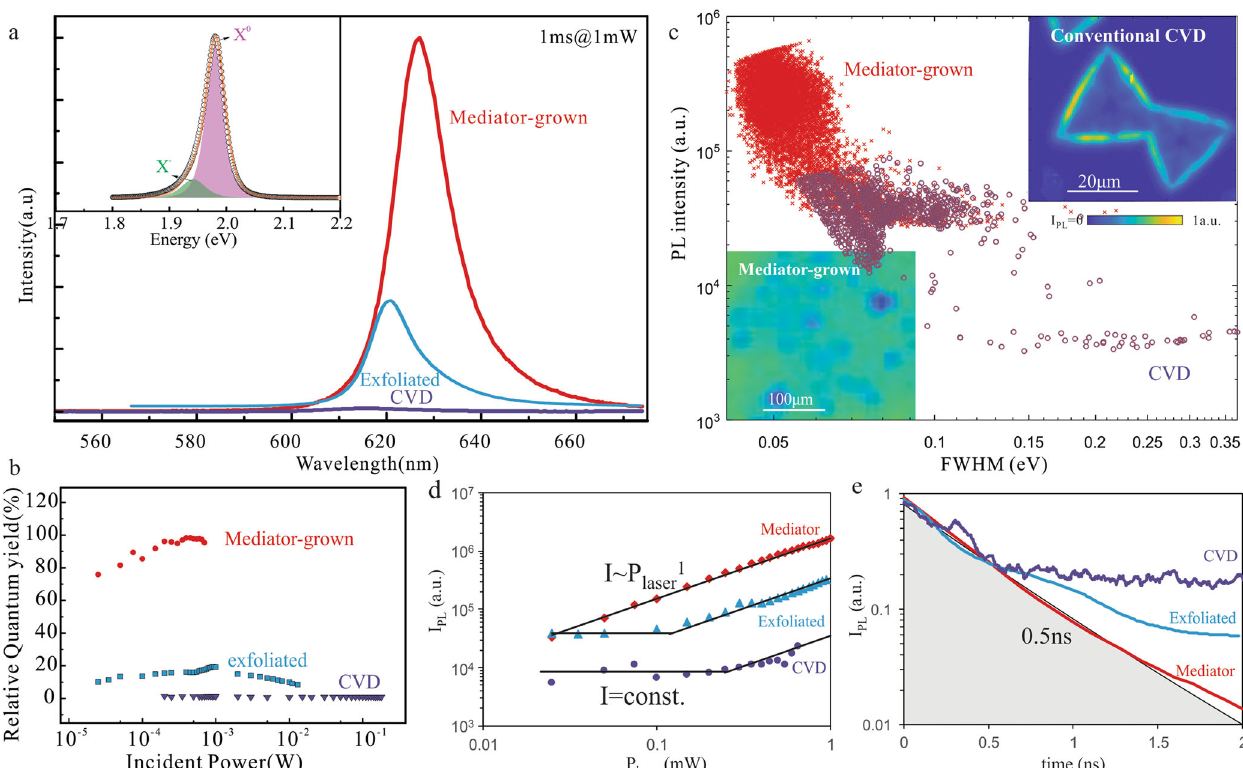
Fig. 3 Optoelectronic properties of mediator-grown WS 2 . a Photoluminescence of WS 2 from different sources, (inset) PL spectrum of mediator-grown CVD grown WS 2 with deconvolution into neutral exciton ( X 0) and trion ( X -) peak. b Quantum-yield measurements for WS 2 grown with/without a mediator and mechanically exfoliated WS 2 . c Statistical analysis of PL peak width (Lorentzian FWHM) and PL intensity for different locations within samples produced by conventional and mediator-assisted CVD, (insets) spatial maps of emission intensity for different WS 2 sources. d PL intensity vs excitation power for different WS 2 sources with indication of constant and linearly varying components. e Time-resolved PL intensity for different WS 2 sources with indication of intrinsic response